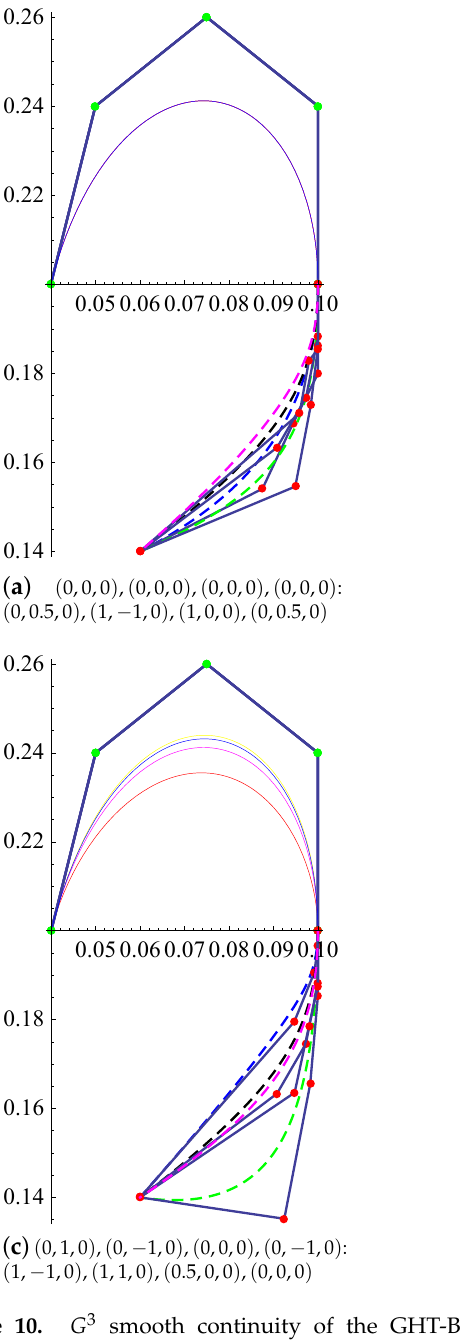
1,0 ) , ( 1,0,0 ) , ( 0,0.5,0 ) ; ( b ) ( 0,0,0 ) , ( 1, −